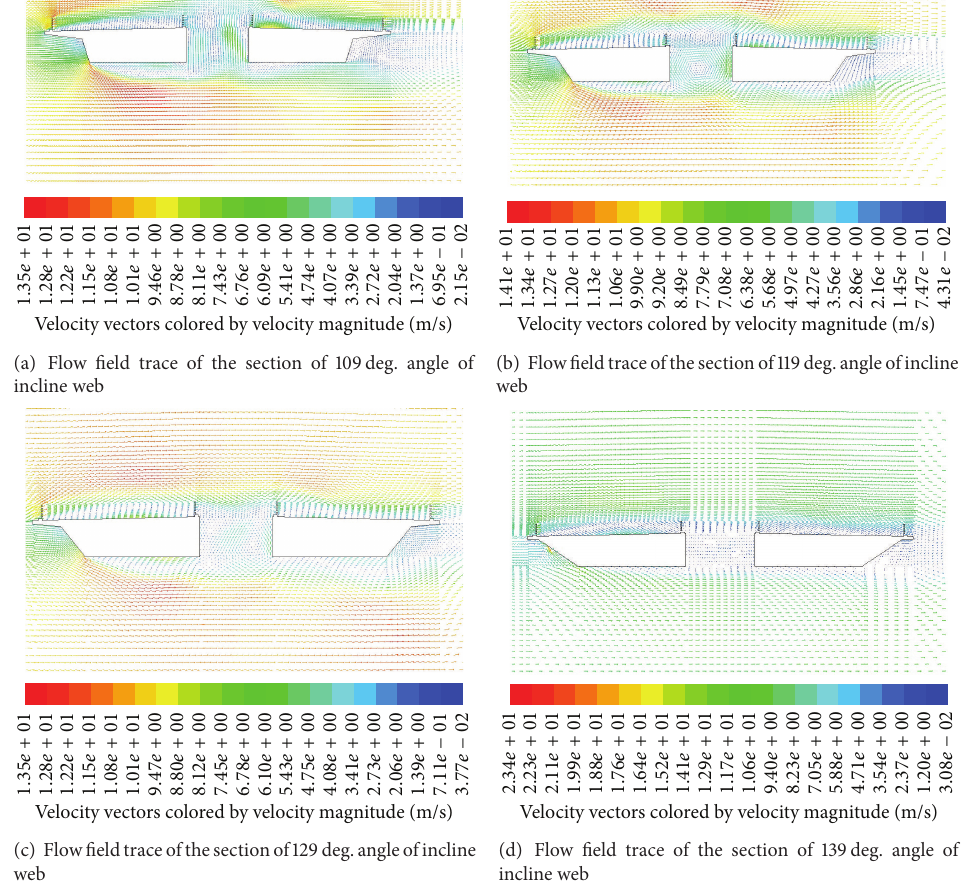
Figure 11: Flow field trace of the section of different angles of inclined web at wind attack angle of 0 deg. (10m/s).